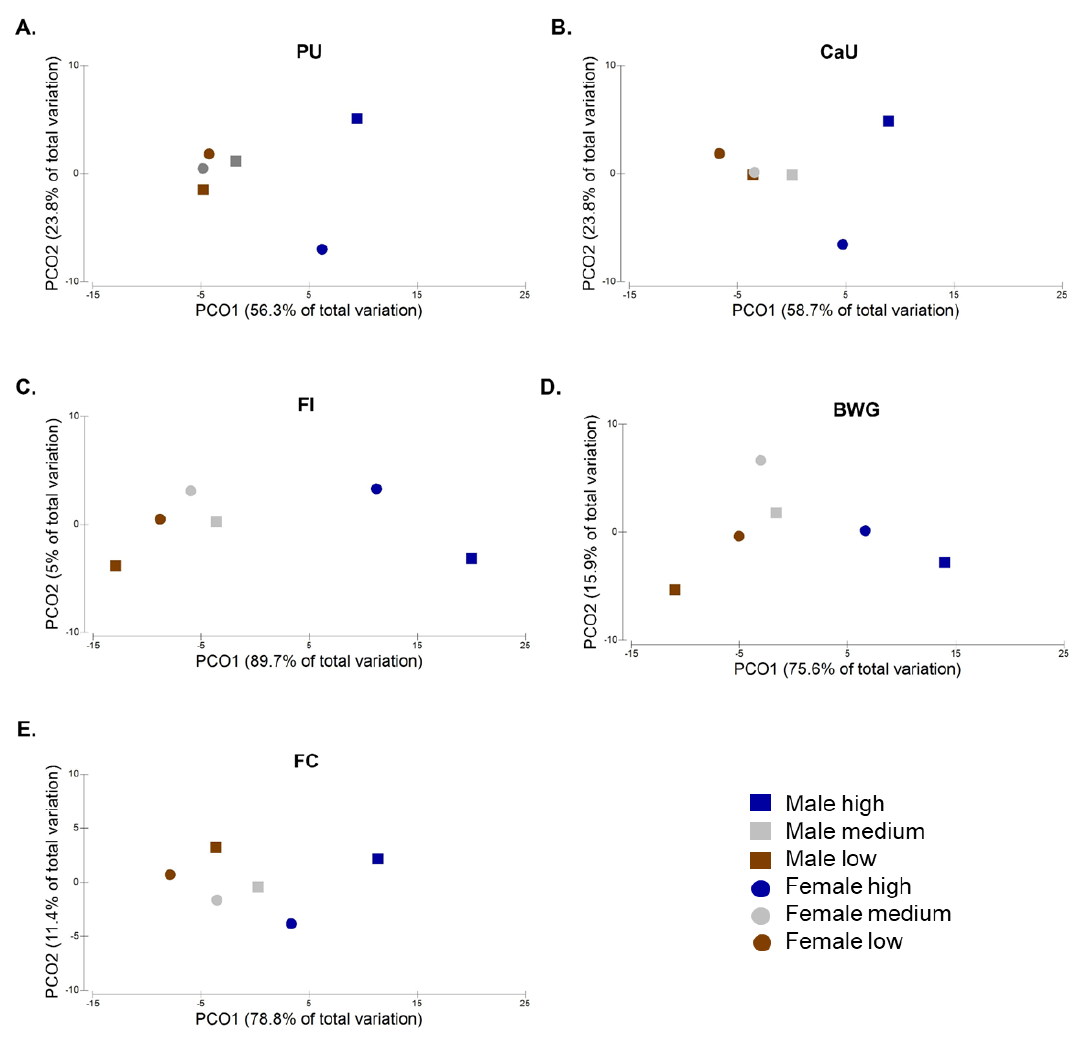
Figure 2. Principal coordinates analysis (PCoA) plots depicting the gender effect on ( A ) phosphorous utilization (PU), ( B ) calcium utilization (CaU), ( C ) feed intake (FI), ( D ) body weight gain (BWG), and ( E ) feed conversion (FC) in the high, medium, and low groups.